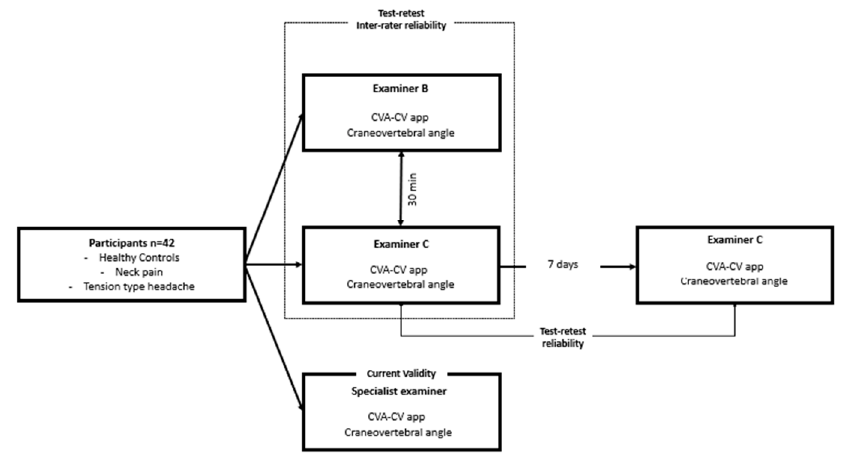
Figure 1. Block diagram and overview of the study design.